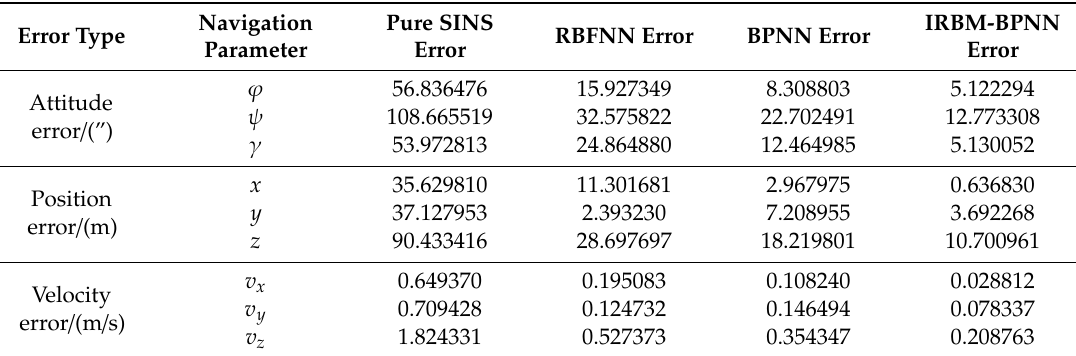
Figure 18. Contrast results of position error using three methods. Table 6. RMS error statistics of navigation parameters.